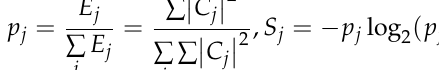
Wavelet Energy and Energy Entropy: Discrete wavelet transform is applied to de- compose fault-phase current signals into three wavelet scales. Wavelet energy E and energy entropy S are calculated for each scale.